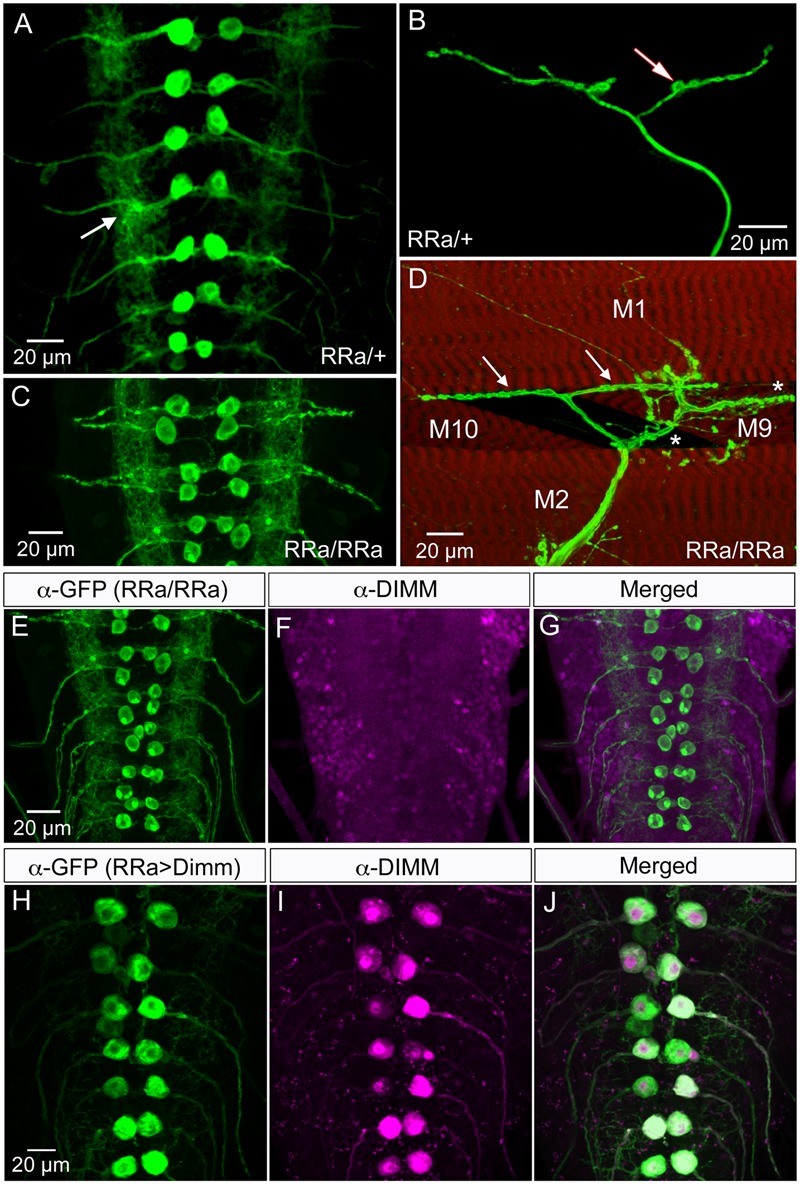
The larval aCC motor neurons are Dimm negative and terminate on abdominal muscle 1. (A) The RRa-Gal4 driver recombined with GFP displays the aCC motor neurons in the ventral nerve cord (one pair in each neuromere) of third instar larva. The aCC dendrites are seen laterally (arrow). (B) The aCC axon termination on muscle 1. One bouton is indicated by arrow. (C) Using a homozygous RRa-Gal4 driver both the anterior aCC and the posterior RP2 neurons display GFP in each segment. (D) With the homozygous RRa-Gal4 driver axon terminations are seen on muscles 1, 2, 9, and 10. The termination from aCC on muscle 1 is indicated by arrows. (E–G) The aCC and RP2 neurons are DIMM negative as seen with double labeling with anti-GFP and anti-DIMM. Scale bar in (A) is also for (F,G). (H–J) Ectopic expression of Dimm in aCC neurons (RRa-Gal4 > Dimm) triggers growth of the cell bodies and strong expression of anti-DIMM, both in nuclei and cytoplasm. Scale bar in (H) is also for (I,J).